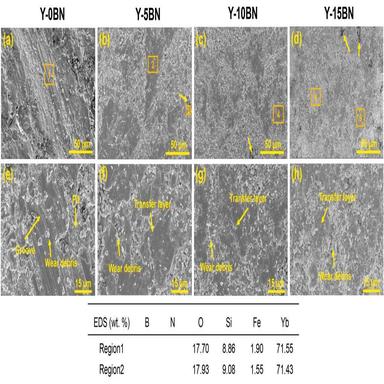
SEM images and EDS results of the wear tracks of the Y–0BN (a, e), Y–5BN (b, f), Y–10BN (c, g), and Y–15BN (d, h) coatings under 0.5 m/s.